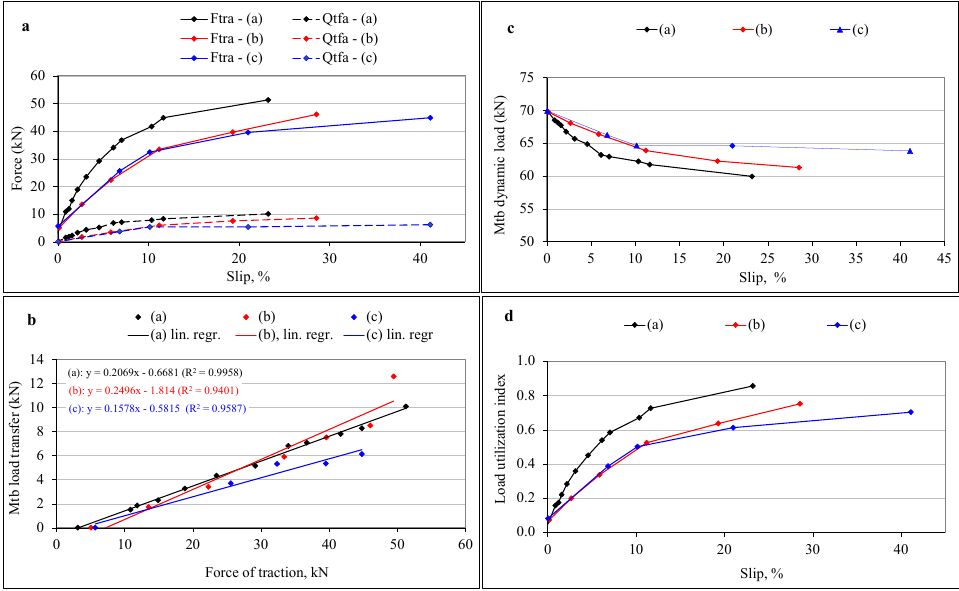
Figure 6. Results of test A on the three surfaces; ( a ) force of traction, F tra , and load transfer, Q tfa , on the tow-hook as functions of the slip; ( b ) linear regression curves of the variation of Q tfa as a function of F tra ; ( c ) decrease of MTB dynamic load, Q DMTB , during the tests (difference between static load and load transfers); ( d ) variation of the index of load utilization, I uQ , as a function of the slip. Table 7. Statistical indicators of the main parameters measured by the MTB for the pre-set values of force of traction of 32 and 36